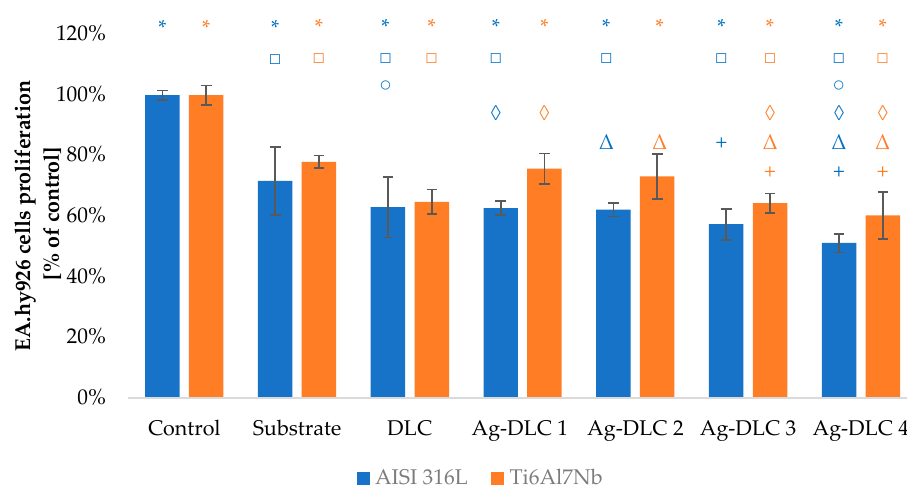
Materials 2021 , 14 , x FOR PEER REVIEW Figure 10. Assessment of proliferation of Saos-2 cells in contact with Cu-DLC coatings. Results of XTT examination.